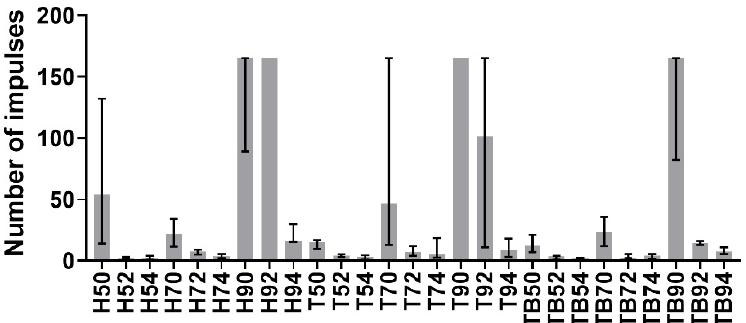
Figure 4. Medians of the number of impulses required for removal. The error bars represent the variability interval between the 25th and the 75th percentiles of each data group.